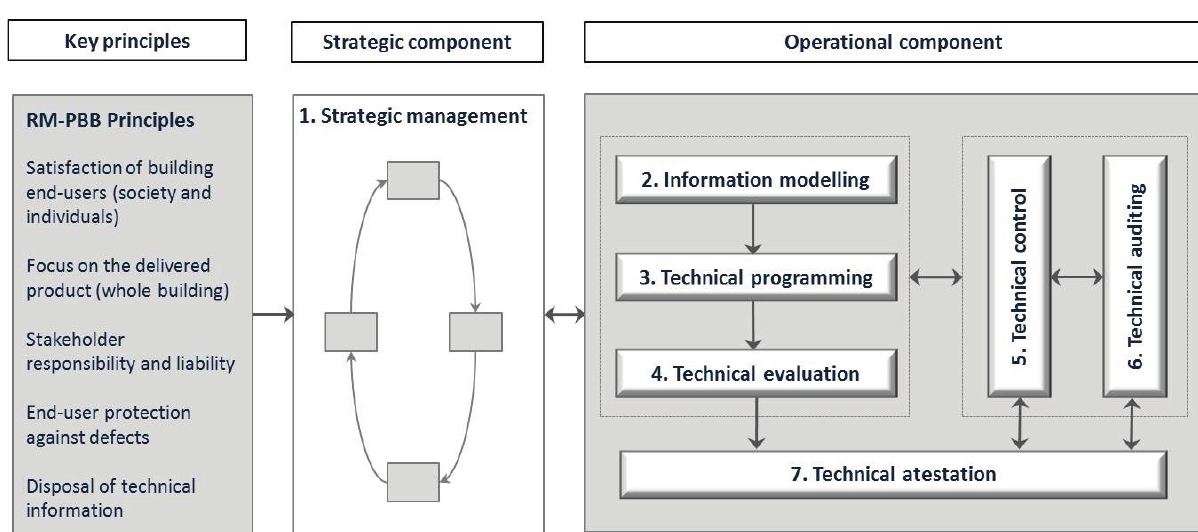
Fig. 3. Final version of a framework for managing the engineering risks of performance-based